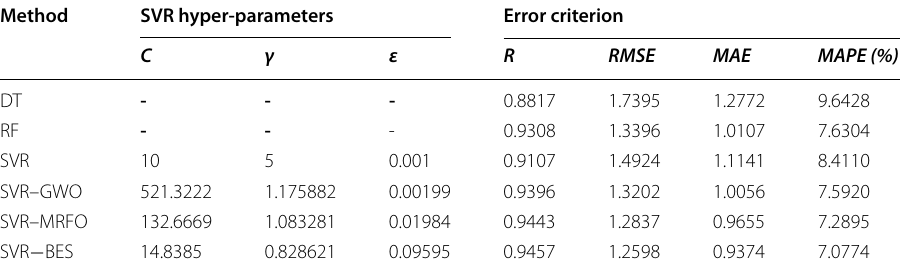
Table 3 Goodness-of-fit results of SVR